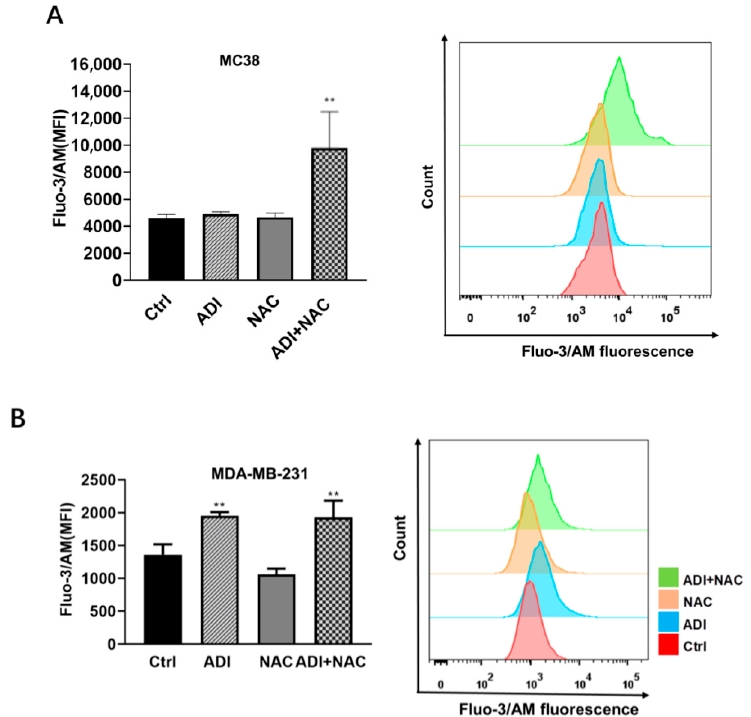
Figure 5. Changes in intracellular Ca 2+ concentrations of ( A ) MC38 and ( B ) MDA-MB-231 cells by ADI and NAC treatment for 48 h were assayed by Fluo-3/AM staining. MFI: mean fluorescence intensity. ** p < 0.01 (comparison to the